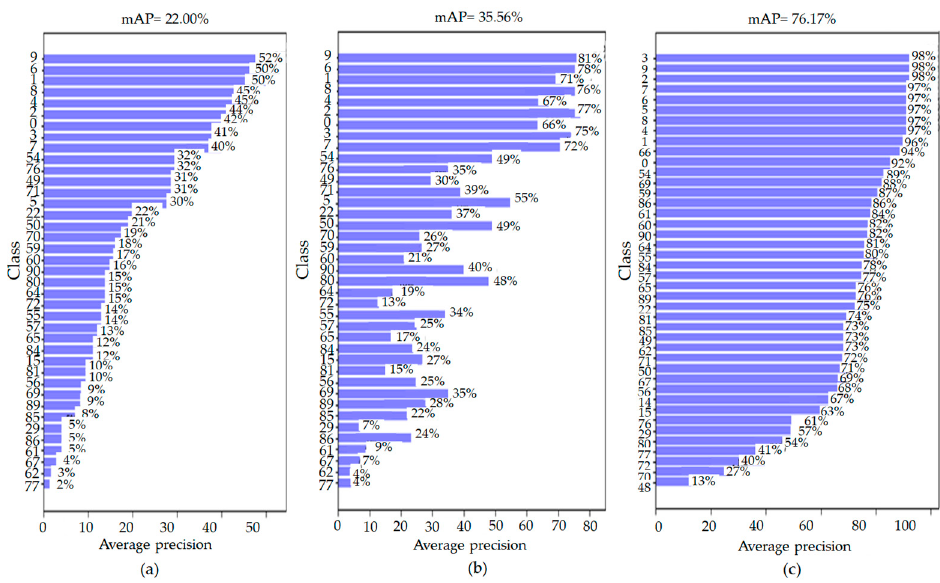
Figure 14. Failure examples of character recognition results. ( a ) Ground-truth labels on HR images and ( b ) the proposed SR (4 × ) and character recognition results obtained from LR images. Two characters were masked due to privacy policies.